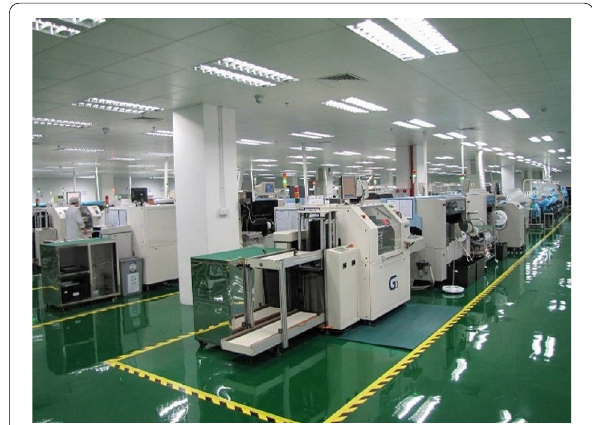
Figure 4 Production line of